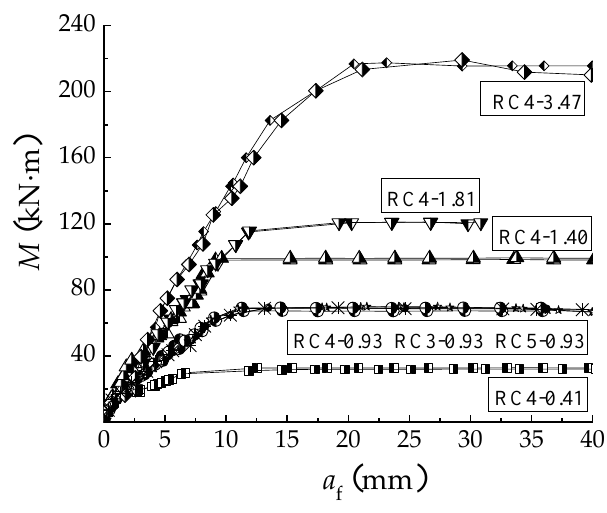
Figure 8 . Mid-span deflection vs moment curves of test beams.